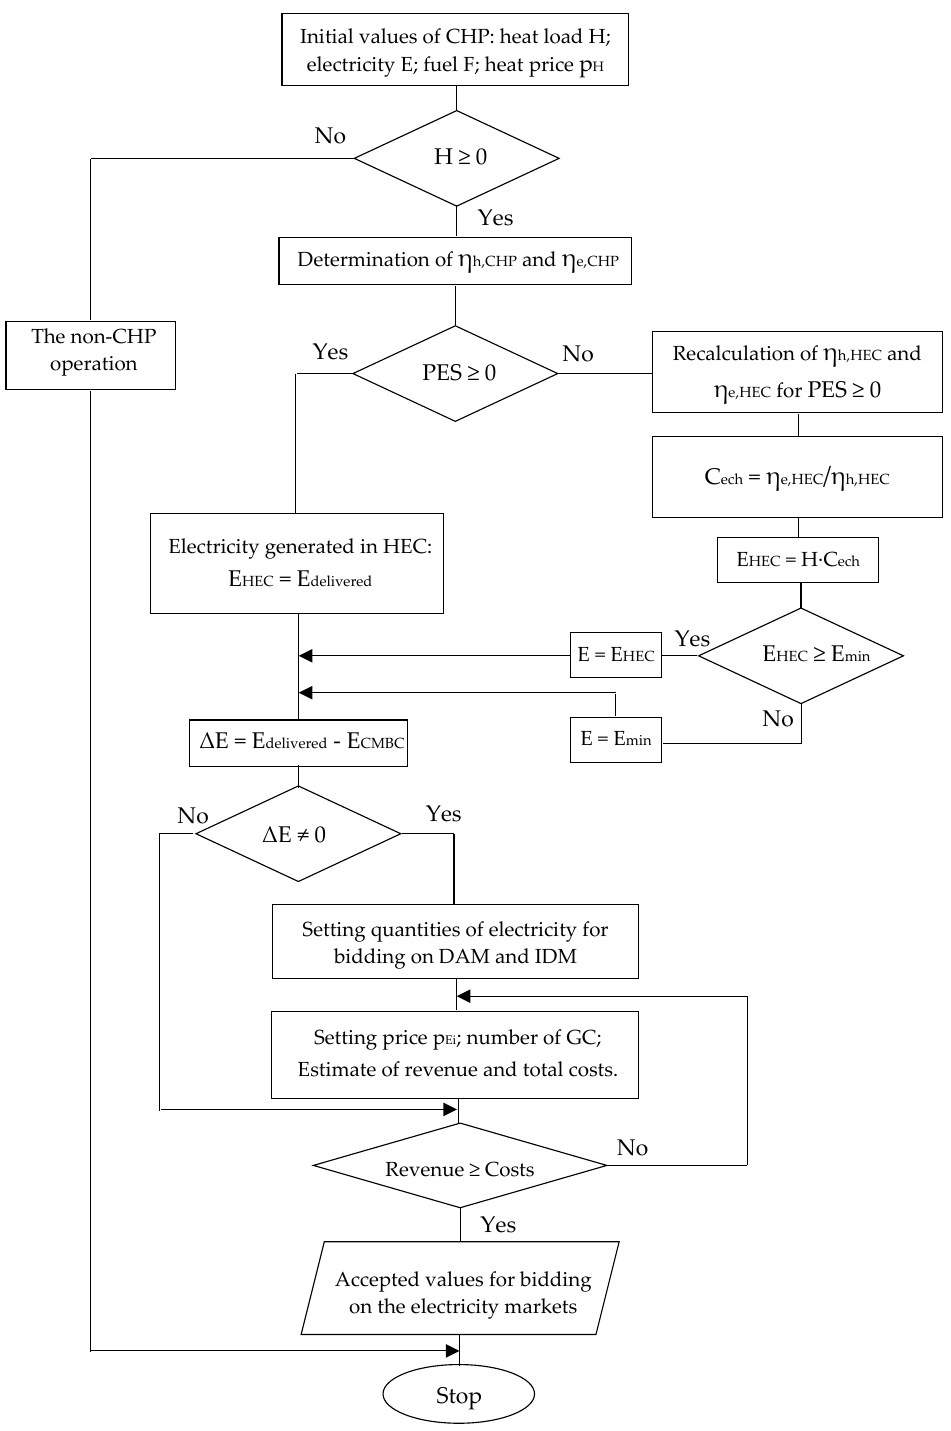
Figure 4. Algorithm for determining the operating strategies of the CHP plant.